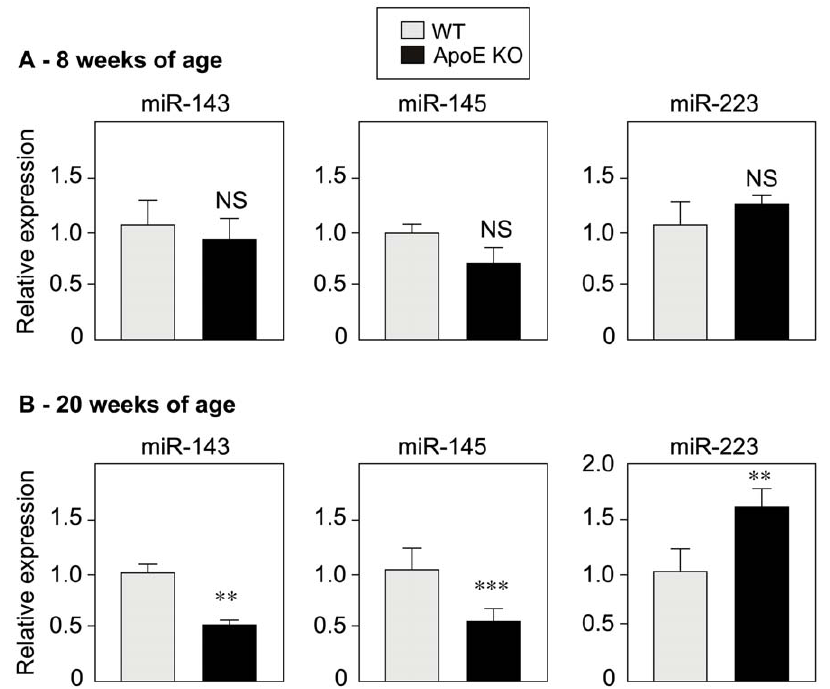
Figure 6. Expression of miR-143, miR-145 and miR-223 in wild-type and ApoE-KO mice. RNAs extracted from mouse aorta collected from 8- and 20-week-old ApoE-KO and wild-type mice were used for the qPCR expression analysis of miR-143, miR-145 and miR-223. There was significant downregulation of miR-143 and miR-145 and concomitant upregulation of miR-223 in 20-week-old ApoE-KO mice. Data are presented as the mean 6 SD of 4 mice for each